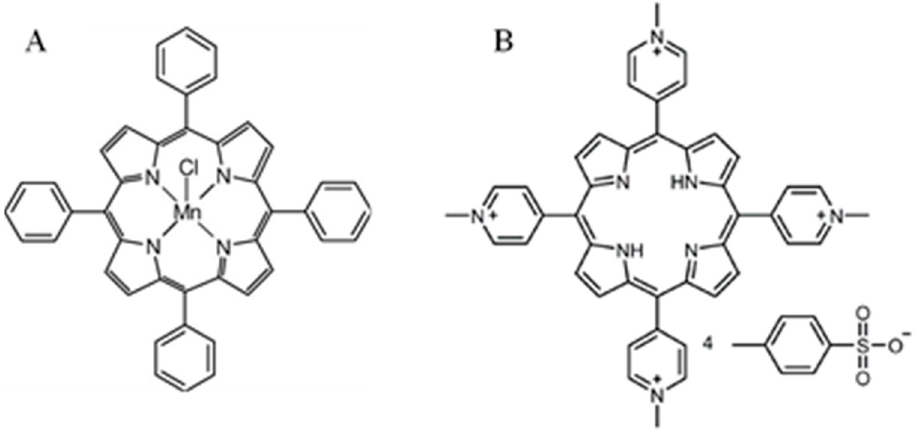
Figure 1. Molecular structures of the porphyrins used in the study; ( A ) 5,10,15,20-tetraphenyl-21H,23H-porphine manganese(III) chloride, and ( B ) 5,10,15,20-tetrakis(1-methyl-4-pyridinio)porphyrin tetra(p-toluenesulfonate).